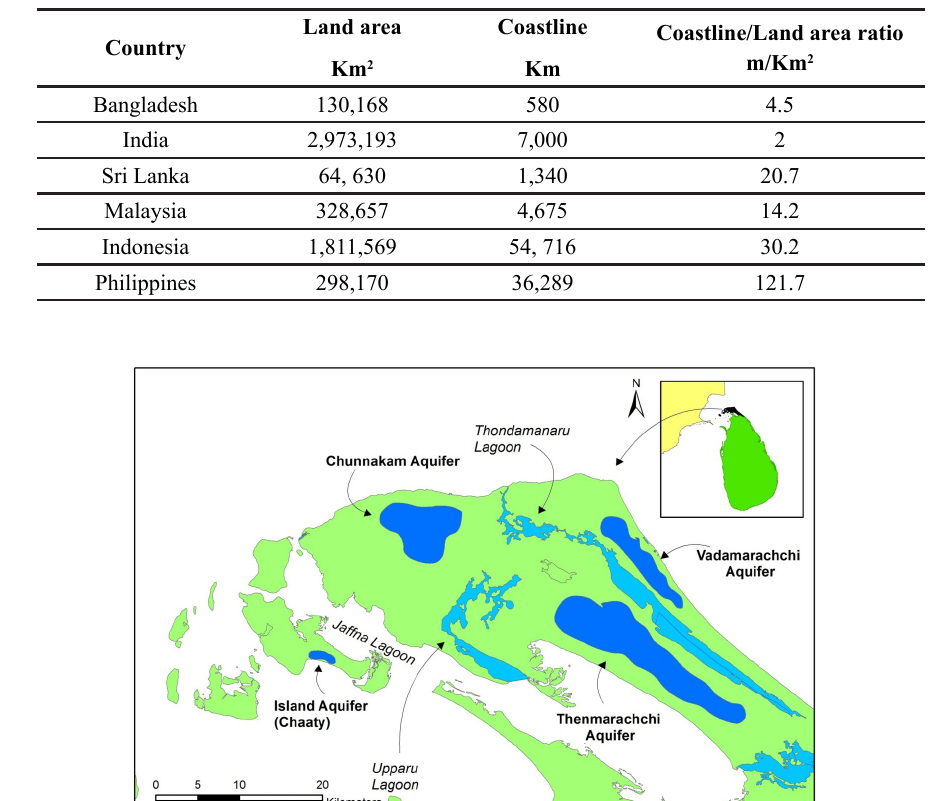
Table 1: Coastline in relation to land cover in selected countries in South Asia. (adapted from Ramasamy et al ., 2015)